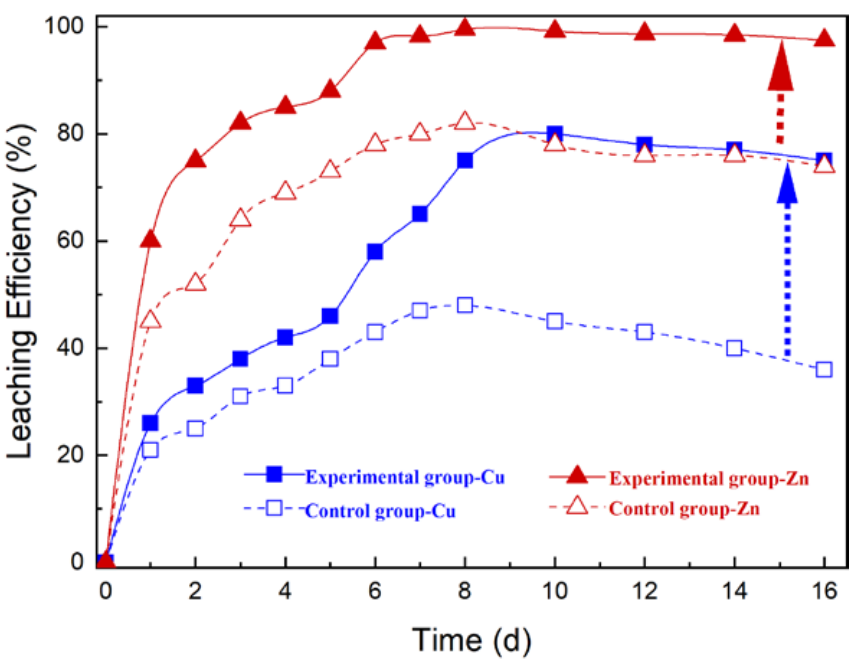
Figure 6. Copper and zinc recovery by the novel artificial microbial community.